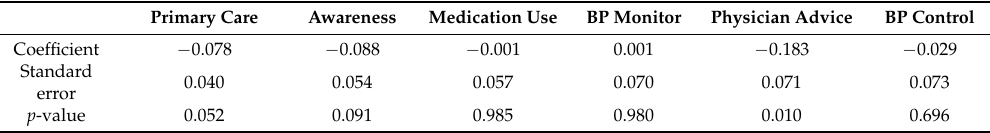
Table 4. Interaction effects between rural health insurance and urban living on hypertension management by logistic regression. Primary Care Awareness Medication Use BP Monitor Physician Advice BP Control Coefficient − 0.078 − 0.088 − 0.001